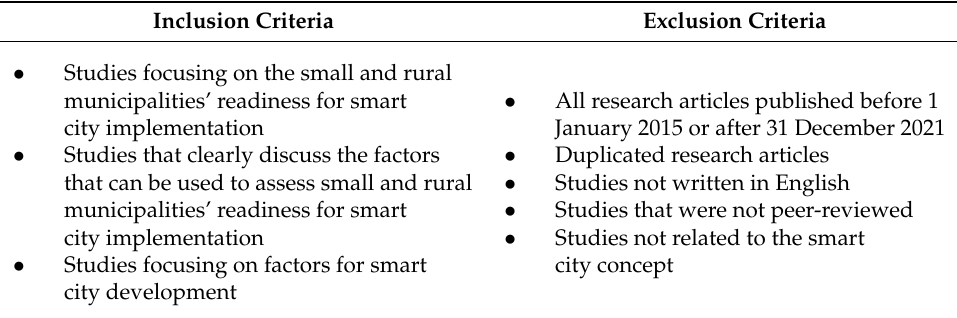
Table 1. Adapted inclusion and exclusion criteria.